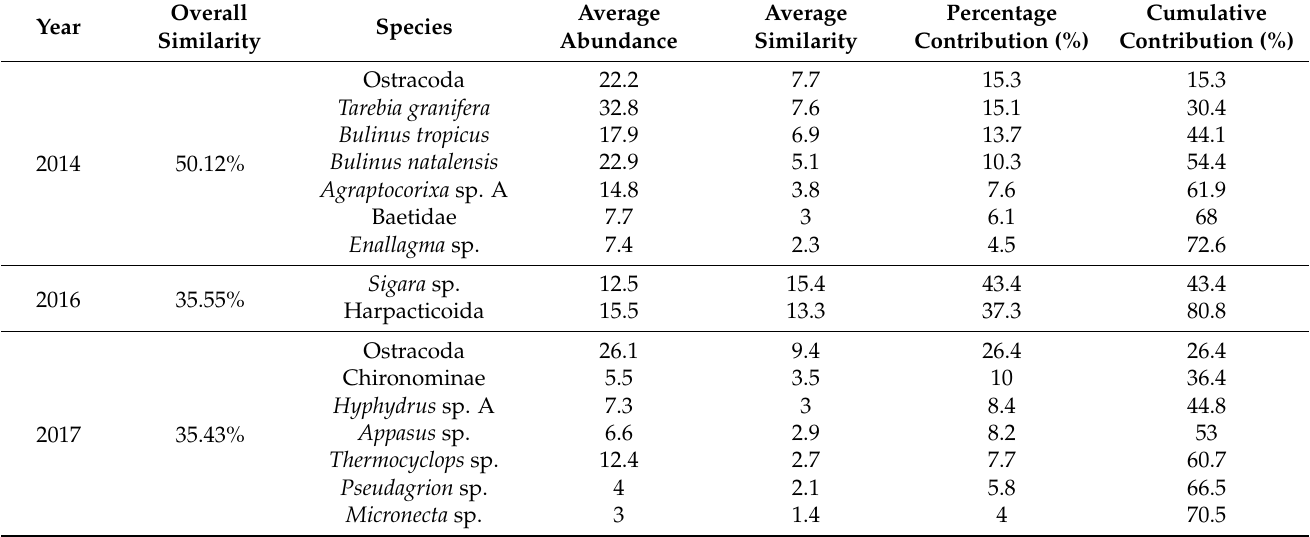
Table 1. Contribution of various aquatic invertebrate taxa to within group similarities in Lake Nyamithi determined through similarity percentage analysis (SIMPER). Groups are based on the hydrologic period in which each survey took place: 2014 (predrought); 2016 (drought) and 2017 (recovery) and were determined using dendrogram and nMDS